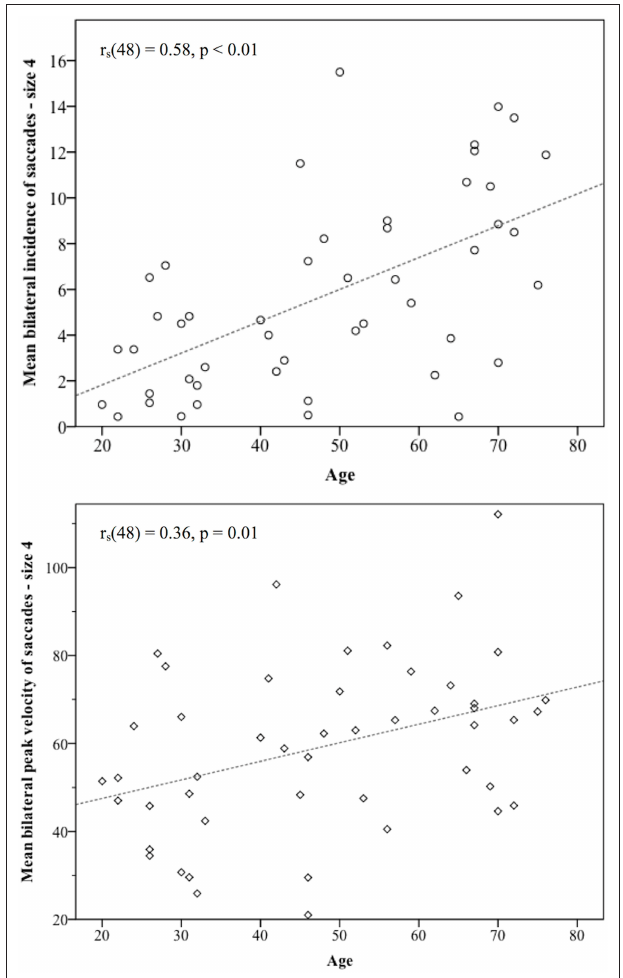
FIGURE 2 | Statistically significant correlations between age and saccade metrics. Incidence of non-pathological saccades was strongly correlated with age [ r s (48) = 0.58], and their peak velocities showed a medium size correlation with age r s (48) = 0.36. As participants became older, the number of saccades they produced and their size in the vHIT trace both increased.